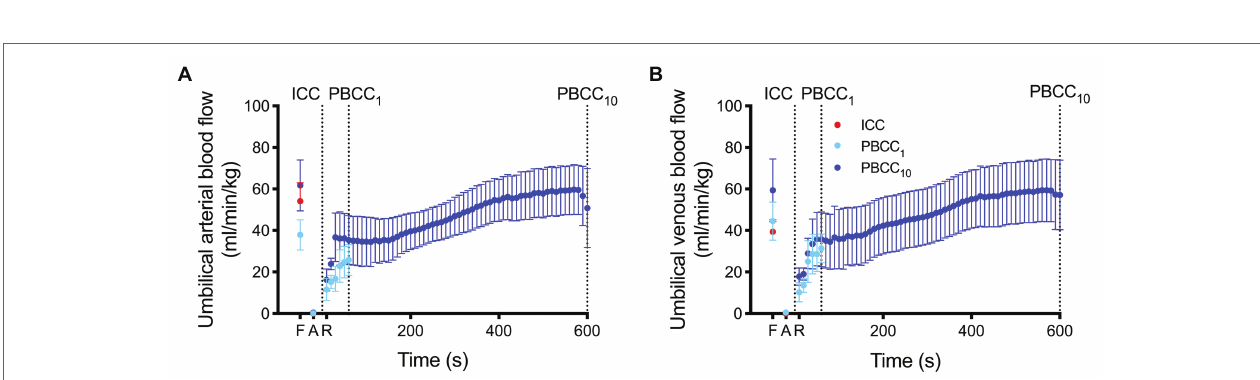
FIGURE 2 | (A) pH, (B) the partial arterial pressure (Pa) of carbon dioxide (CO 2 ), (C) Pa of oxygen (O 2 ), (D) lactate, (E) arterial saturation SaO 2 and (F) cerebral oxygenation (SctO 2 ) measured prior to delivery (fetal, F), at the end of the asphyxial period (A) and upon return of spontaneous circulation (R) in ICC (red), PBCC 1 (light blue), and PBCC 10 (dark blue) lambs. Data are mean ± SD.